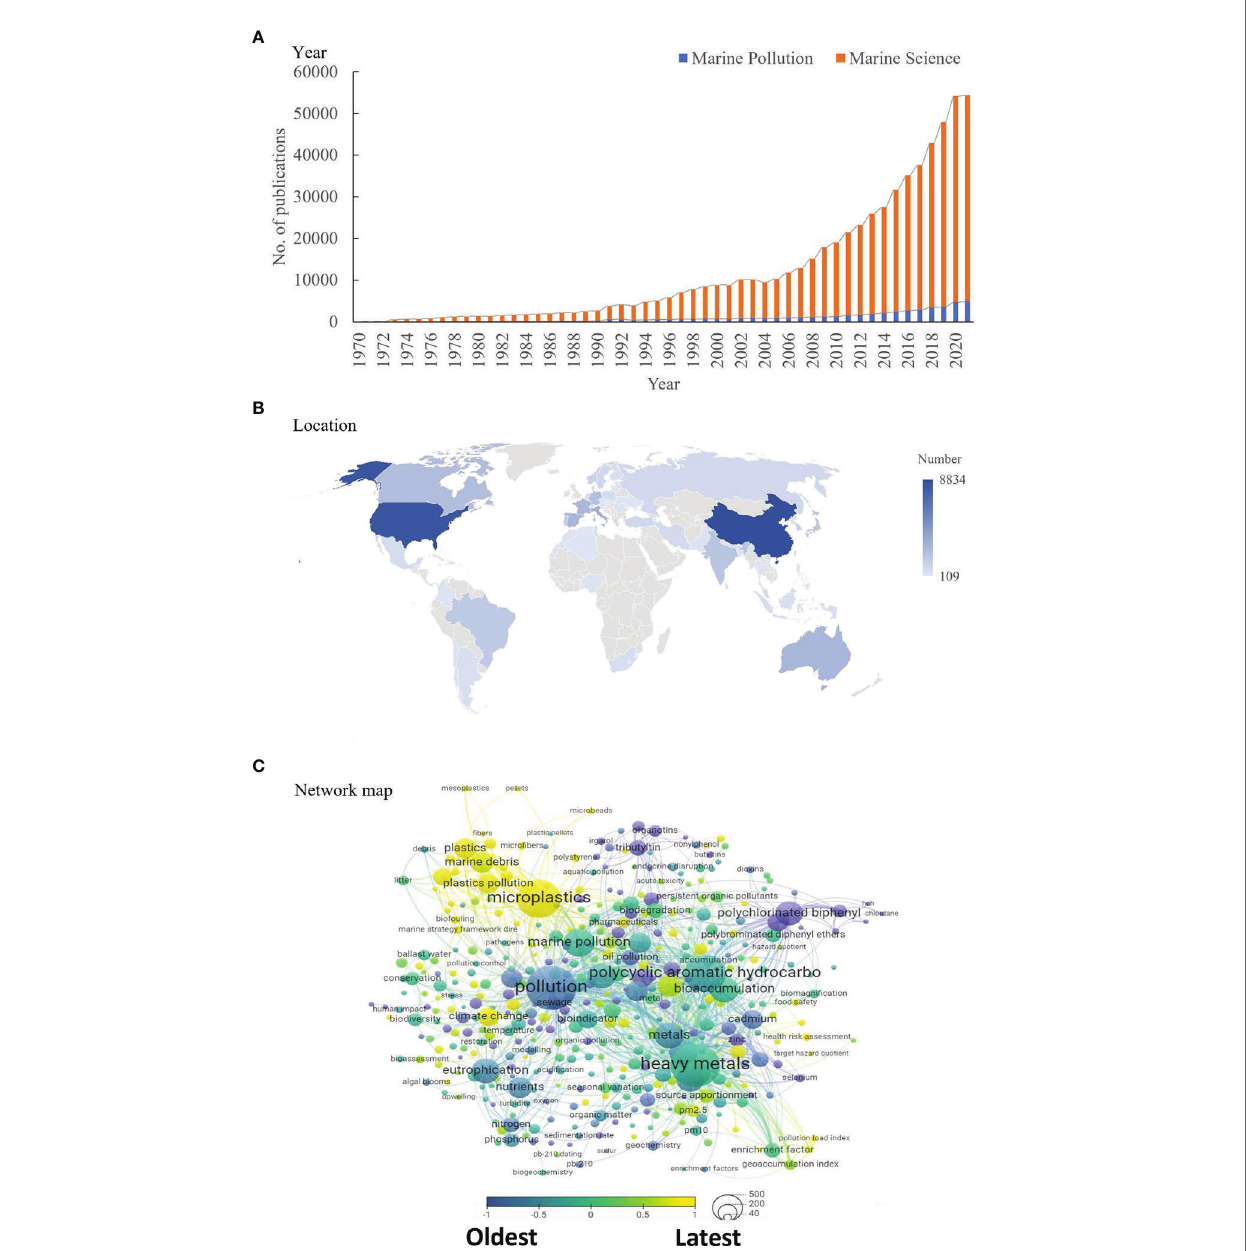
FIGURE 1 | The total number of studies (A) on marine pollution and marine science by year and (B) by country (with more than 100 results) and (C) a network map (online version at https://bit.ly/31Z88uo) showing the most research topics in marine pollution during 1970 to 2021 based on keyword searches in the search engine Web of Science. The search for studies on “ marine pollution ” and “ marine science ” was conducted on 23 rd August 2021. A total of 39,550 research articles on “ marine pollution ” and 568,755 on “ marine science ” were identi fi